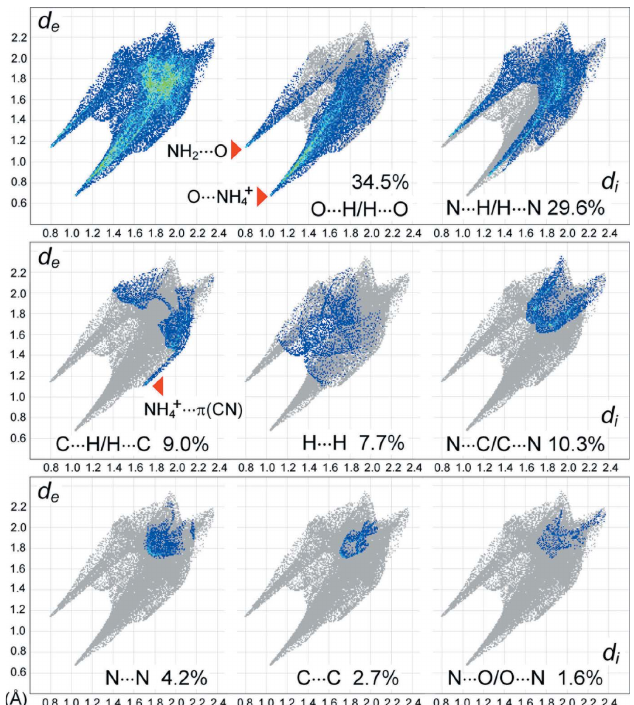
Figure 7 Two-dimensional fingerprint plots for the anions of the title compound, and delineated into the principal contributions of O (cid:2)(cid:2)(cid:2) H/H (cid:2)(cid:2)(cid:2) O, N (cid:2)(cid:2)(cid:2) H/ H (cid:2)(cid:2)(cid:2) N, C (cid:2)(cid:2)(cid:2) H/H (cid:2)(cid:2)(cid:2) C, H (cid:2)(cid:2)(cid:2) H, N (cid:2)(cid:2)(cid:2) C/C (cid:2)(cid:2)(cid:2) N, N (cid:2)(cid:2)(cid:2) N, C (cid:2)(cid:2)(cid:2) C and N (cid:2)(cid:2)(cid:2) O/ O (cid:2)(cid:2)(cid:2) N contacts. Other minor contributors are C (cid:2)(cid:2)(cid:2) O/O (cid:2)(cid:2)(cid:2) C contacts (0.3%).